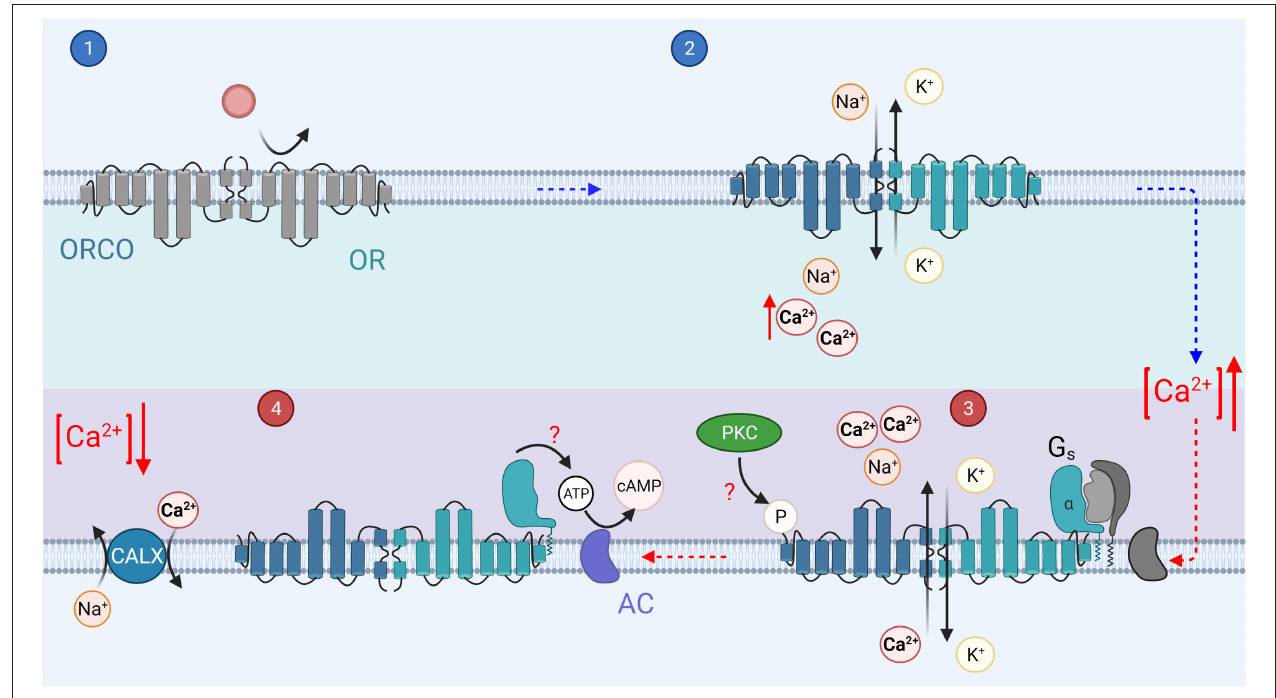
FIGURE 5 | The invertebrate olfactory transduction cascade: In invertebrates, the ORs are 7 transmembrane domain receptors, which associate with a co-receptor, Orco. Upon binding of an odorant (step 1), the OR/Orco co-receptor channel pore opens, allowing the influx of cations, Ca 2 + and Na + (step 2). It is possible that a G protein mediated pathway regulates the sensitivity of the channels, odorant binding activates G s (step 3). The G s α subunit then in turn activates adenylyl cyclase to create cAMP from ATP, which may mediate sensitization of the odorant response (step 4). Phosphorylation by PKC of the Orco receptor may mediate the olfactory neuron sensitization (step